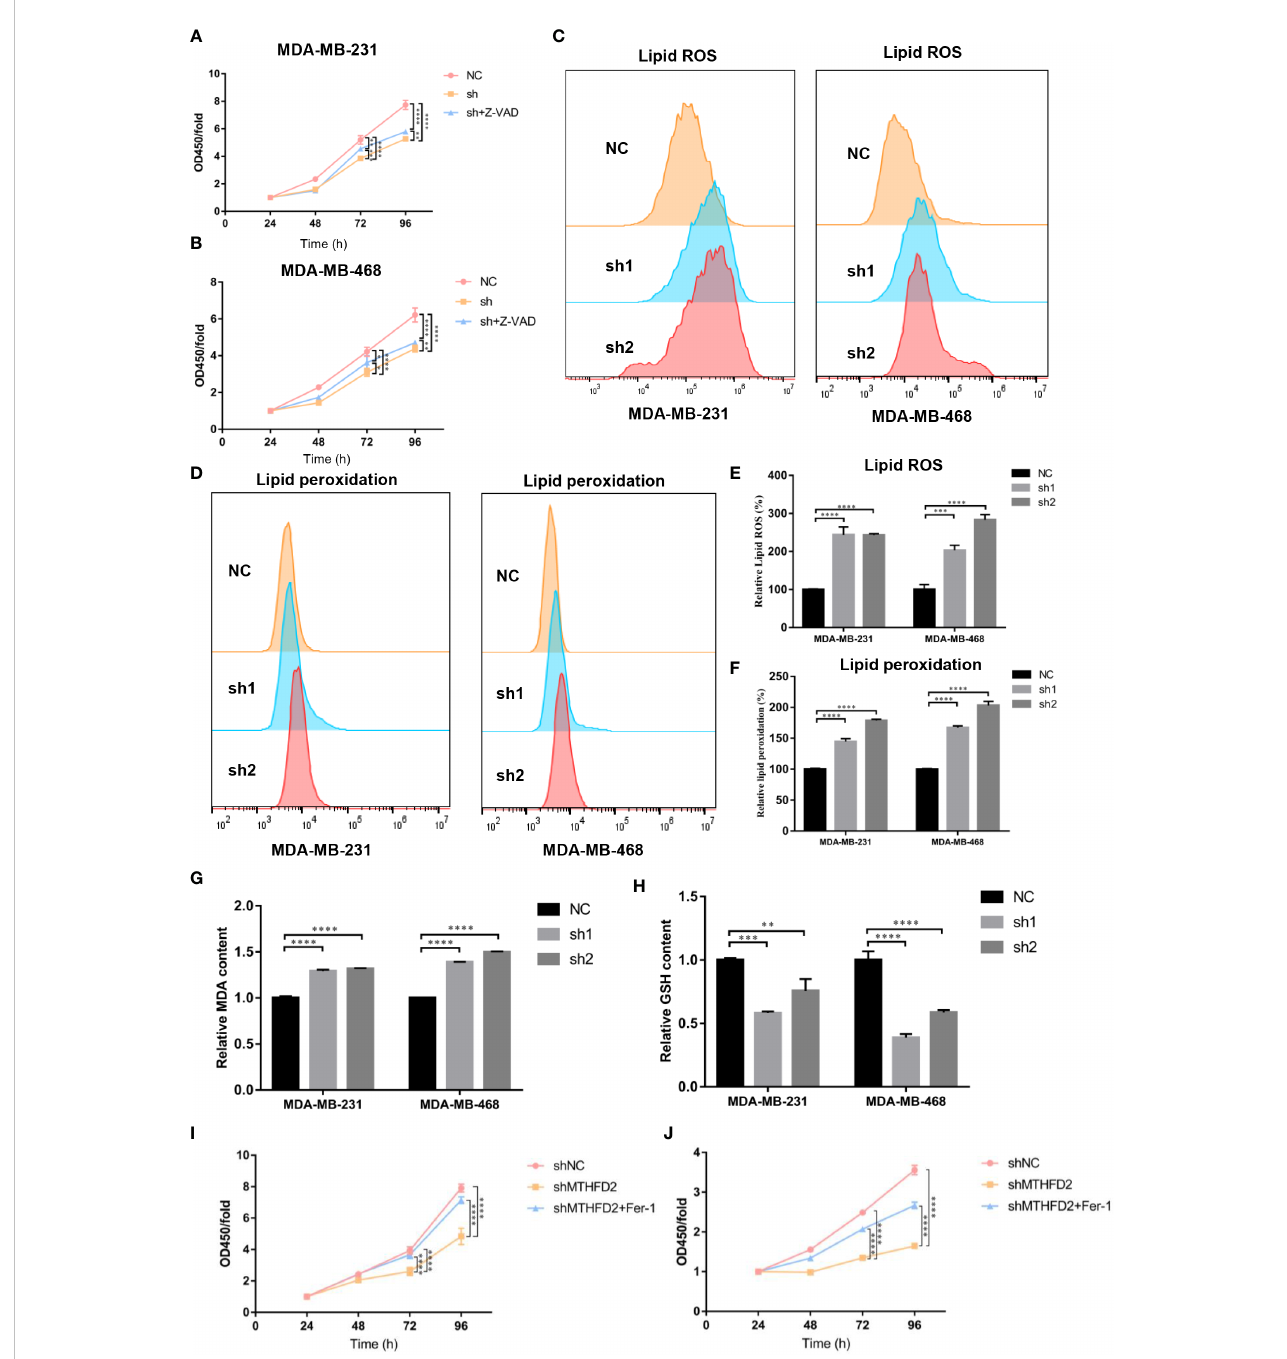
FIGURE 10 Effect of MTHFD2 knockdown on ferroptosis in TNBC cells. (A, B) CCK8 assays were used to measure the effect of MTHFD2 knockdown in MDA-MB-231 and MDA-MB-468 cell lines with Z-VAD-FMK (20 µm/L). (C, D) Lipid ROS and lipid peroxidation content in MDA-MB-231 and MDA-MB-468 cell lines (detected by fl ow cytometry). (E, F) Statistical results of lipid ROS and lipid peroxidation content (measured by fl ow cytometry). (G) Effect of MTHFD2 knockdown on MDA in MDA-MB-231 and MDA-MB-468 cell lines. (H) Effect of MTHFD2 knockdown on GSH in MDA-MB-231 and MDA-MB-468 cell lines. (I, J) CCK8 as were says used to measure the effect of MTHFD2 knockdown in MDA-MB-231 and MDA-MB-468 cell lines with ferrostatin-1 (1 µm/ L). ns: p ≥ 0.05, * p <0.05, ** p <0.01, *** p <0.001, **** p